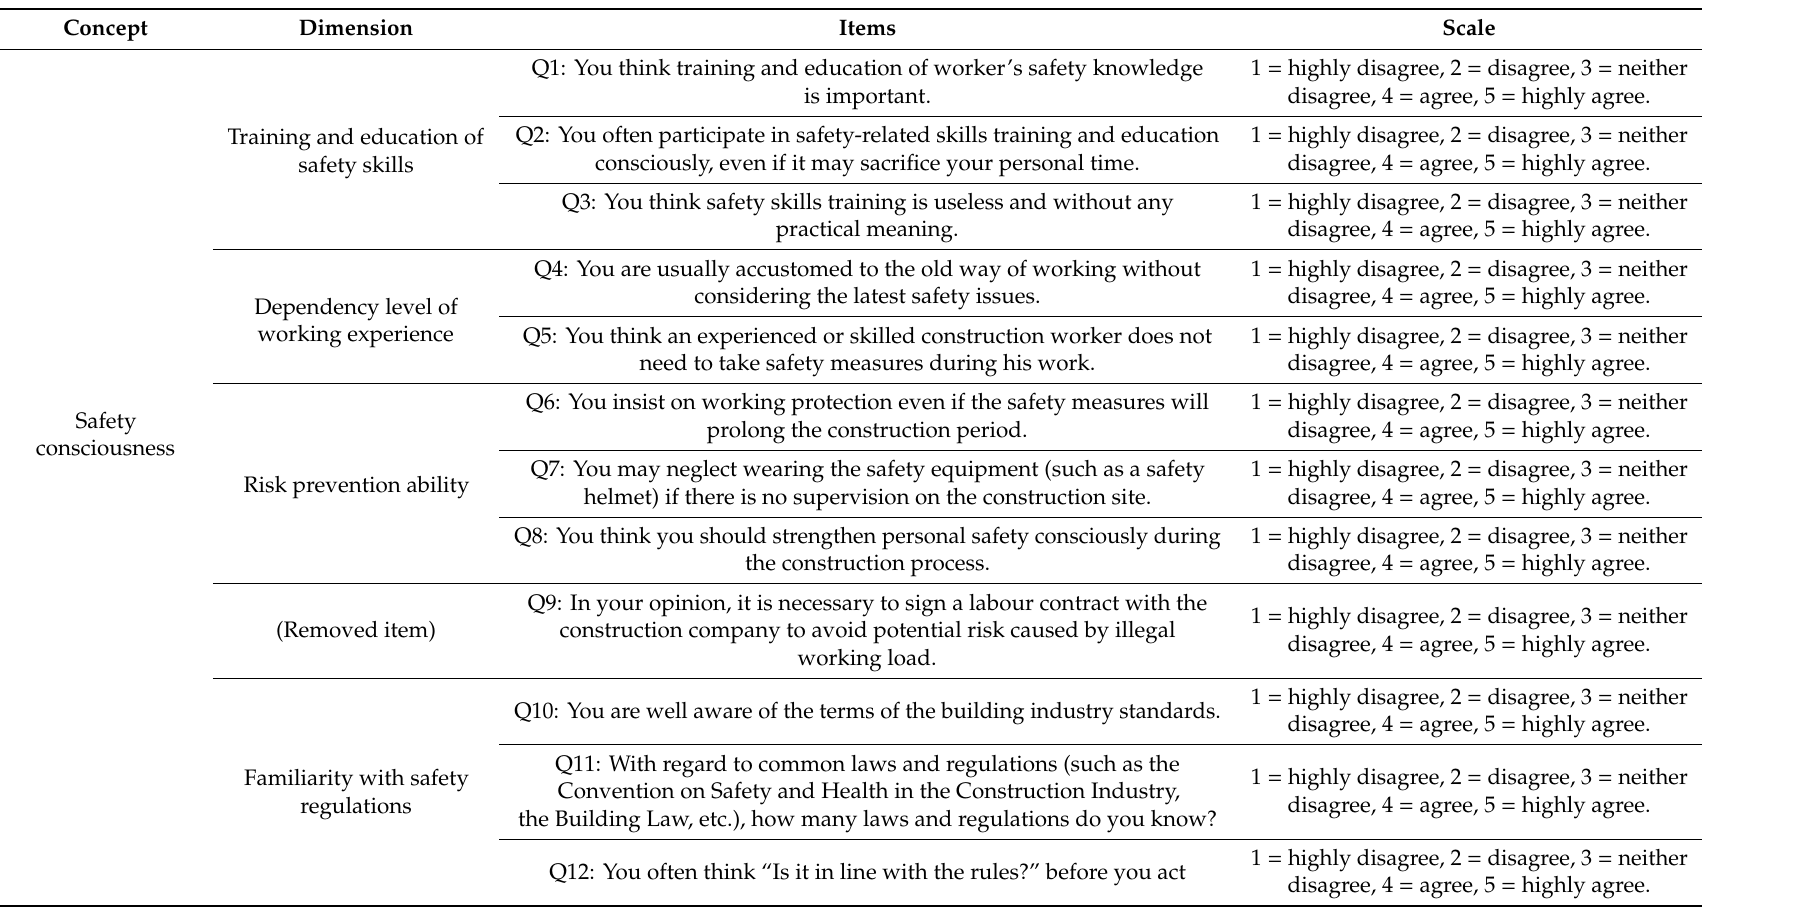
Table A2. Content of the